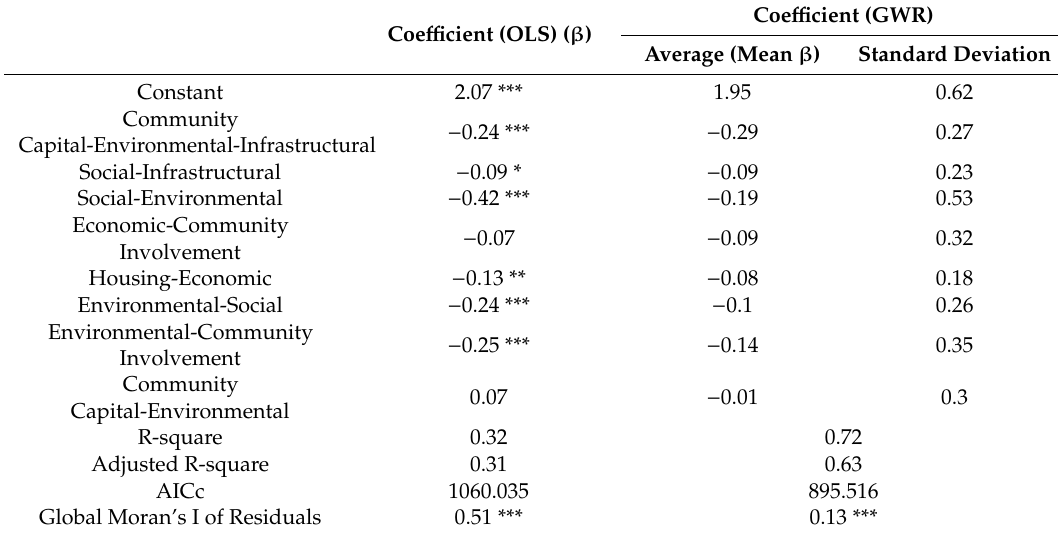
Table 4. Impacts of disaster resilience components on property damages caused by coastal hazards using ordinary least squares (OLS) and geographically weighted regression (GWR)